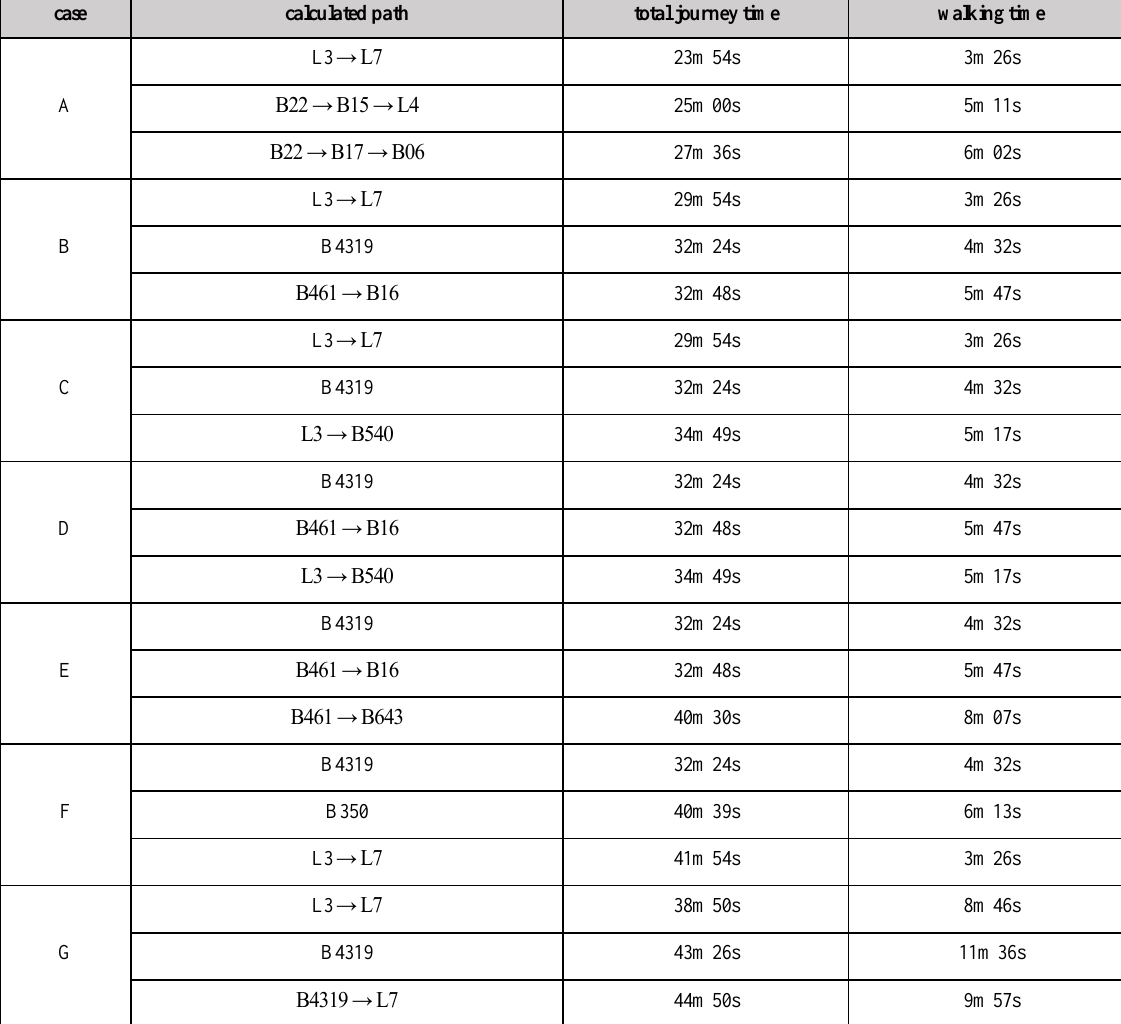
Table 3. Examples of paths found of an O-D (Nambu Stn. to Isu Stn. at 11:00am, K=3) (L#: subway line number, B#: bus